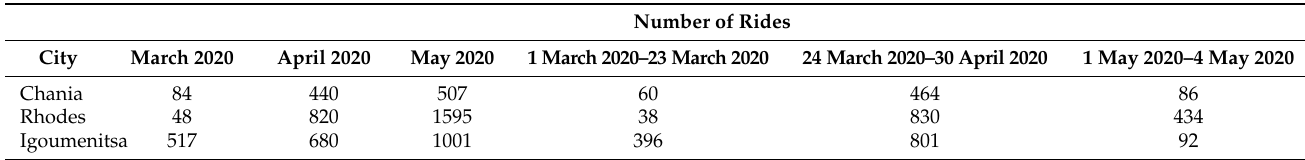
Table 4. Number of rides for Igoumenitsa, Chania, and Rhodes during time periods before and during the lockdown.